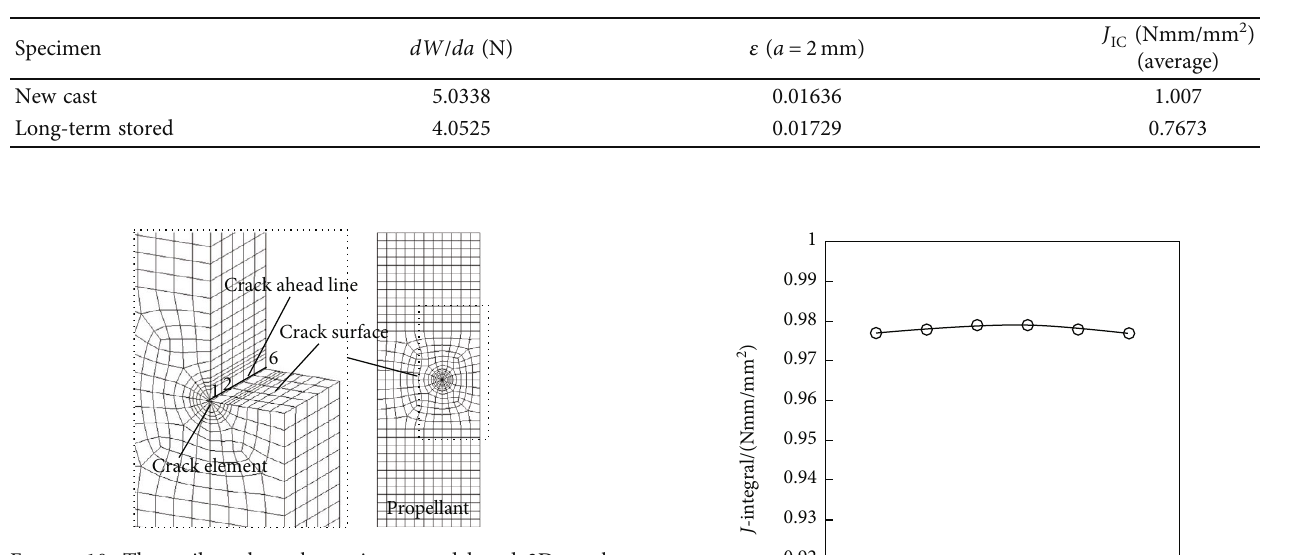
Table 2: The sizes of propellant unilateral crack specimen.